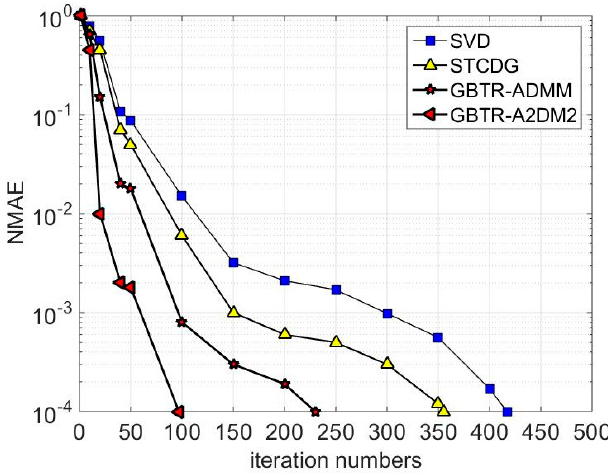
Figure 10. Variation of recovery errors in respect to iteration numbers for different algorithms.